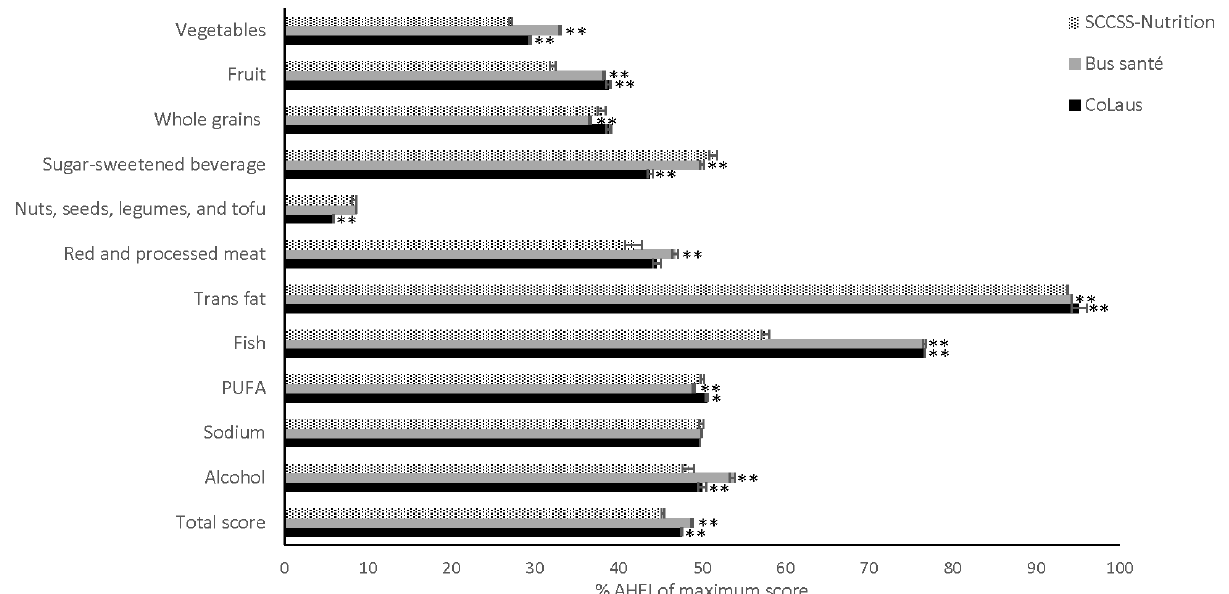
Figure 2. Percentages of Alternate Healthy Eating Index a,b of maximum score with 95% CIs in childhood cancer survivors (SCCSS-Nutrition) and the general population in Switzerland (Bus Santé and CoLaus) c a Adapted from Chiuve et al. [40] b Intermediate food intake was scored proportionately between the minimum score zero and the maximum score ten. The maximal total AHEI score was 110. c Adjusted for sex, age at survey, and if applicable ICCC-3 diagnosis, general population is additionally standardized on sex and age at survey according to CCSs. * p < 0.05 compared to CCSs. ** p < 0.001 compared to CCSs. Table 2. Diet quality in childhood cancer survivors by clinical characteristics (retrieved from AN- COVA) a